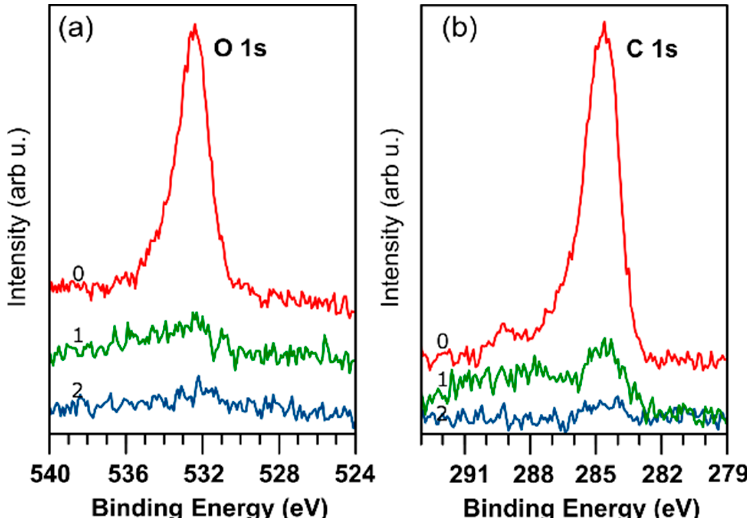
Figure 1. XPS spectra of ( a ) the O 1s and ( b ) C 1s for the GeS sample. ‘0 ′ corresponds to the fresh surface and ‘1 ′ and ‘2 ′ to Ar-ion sputtered for 4 and 6 min, respectively.